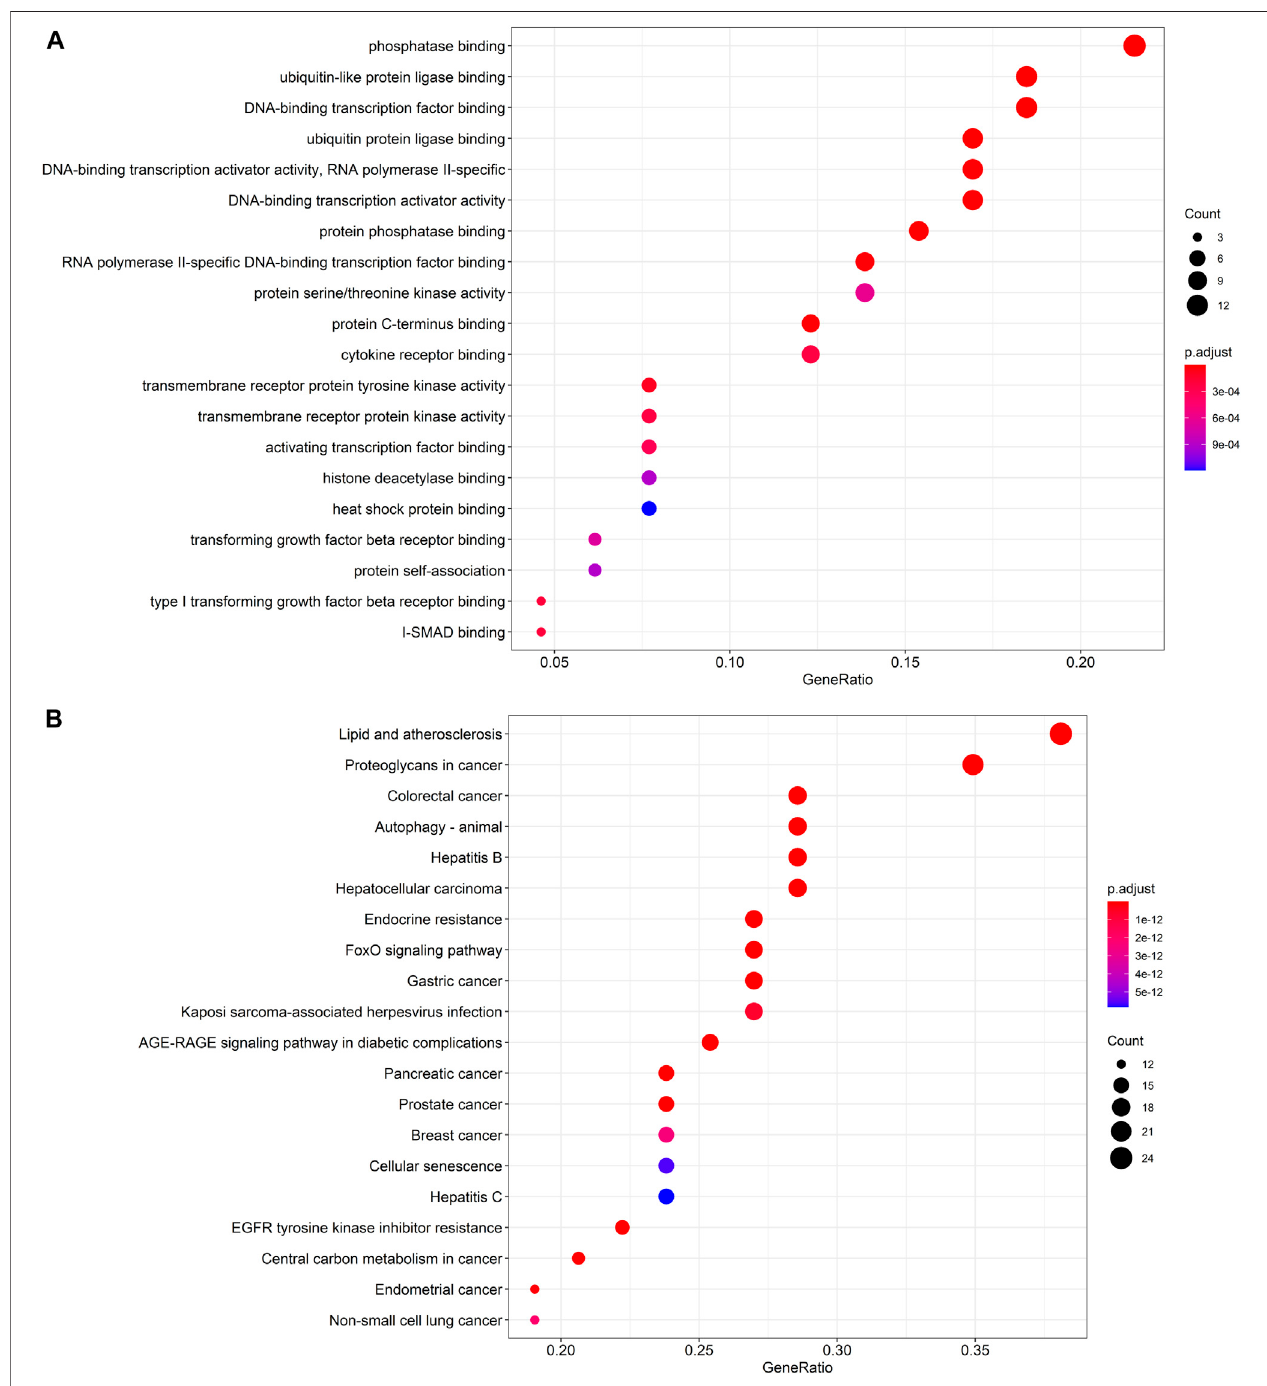
FIGURE 4 | Dotplots of GO analysis (A) , KEGG analysis (B) and DO enrichment analysis (C) of proteins or genes previously reported in the literature.